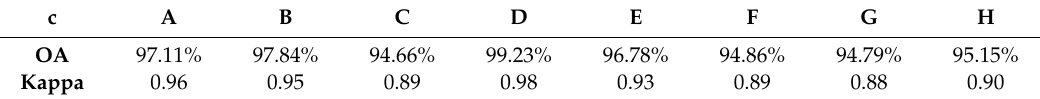
Table 4. The coe ffi cient values of overall classification accuracy (OA) and Kappa in the eight test areas.